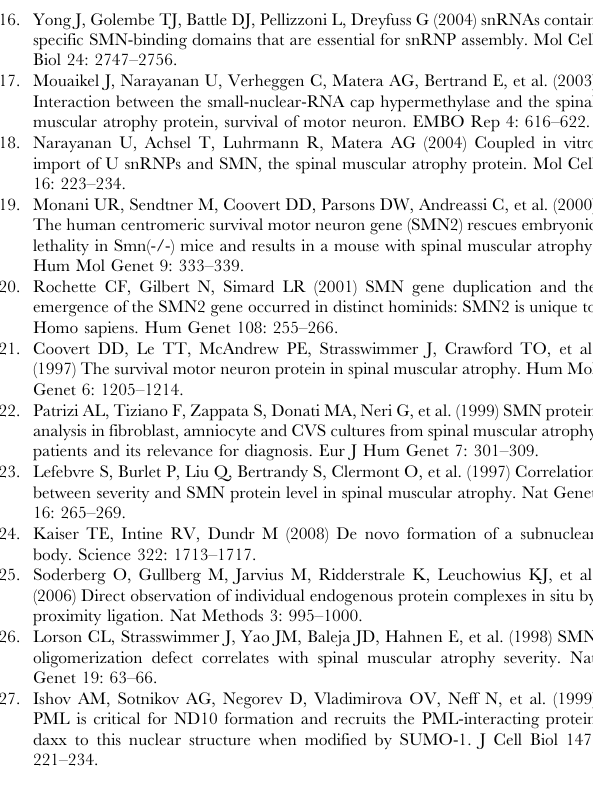
indicated siRNA oligos for 48 h. (C) IP of endogenous SMN from U2OS cells pretreated with the indicated siRNA oligos for 48 h. (D) IF of U2OS cells treated with the indicated siRNA oligos for 48 h, followed by staining with Gemin3- (ab10305, Abcam) and WRAP53-specific antibodies. Arrows indicate a gem. (E) IF staining of WRAP53 and Gemin3 (ab10305, Abcam) in U2OS cells transiently transfected with Flag-tagged WRAP53 for 16 h. Arrows indicate an untransfected cell. (F) IF of U2OS cells treated with the indicated siRNA oligos for 48 h, followed by staining with SMN-, Gemin2-, Gemin3- (sc-57007, Santa Cruz Biotechnology), and WRAP53-specific antibodies. Figure S6 WRAP53-depleted cells show altered localiza- tion of Sm but no change in intracellular distribution of Sm. (A) IF of U2OS cells treated with the indicated siRNA oligos for 48 h, followed by staining with Sm-, coilin-, and WRAP53- specific antibodies. (B) WB analysis of Sm levels in fractionated U2OS cells treated with the indicated siRNA oligos. Table S1 PCR primers for cloning of EGFP-WRAP53 and Flag-SMN